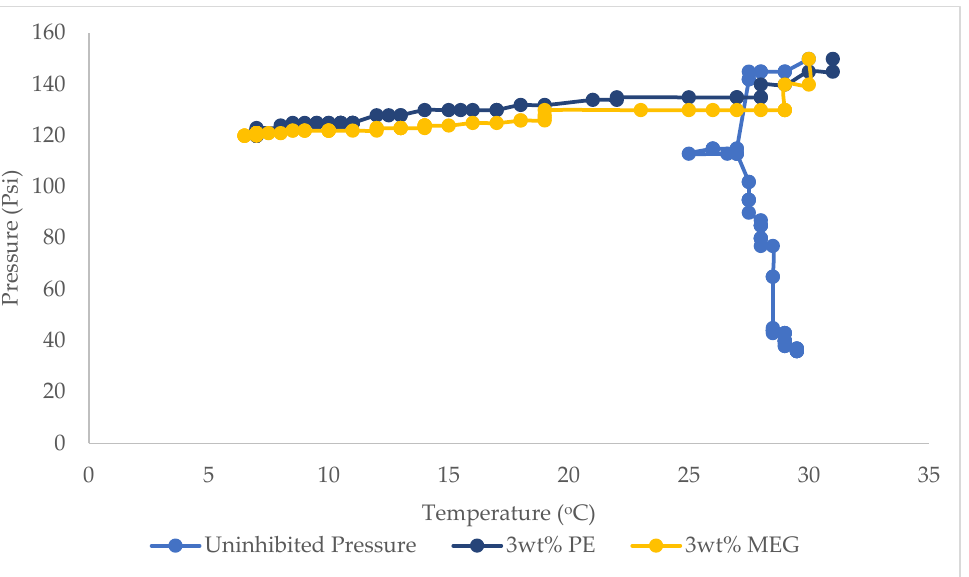
Figure 9. Pressure versus Temperature for 3 wt% Plant Extract (PE), Mono Ethylene Glycol (MEG), and Uninhibited Experiment (water and Gas).